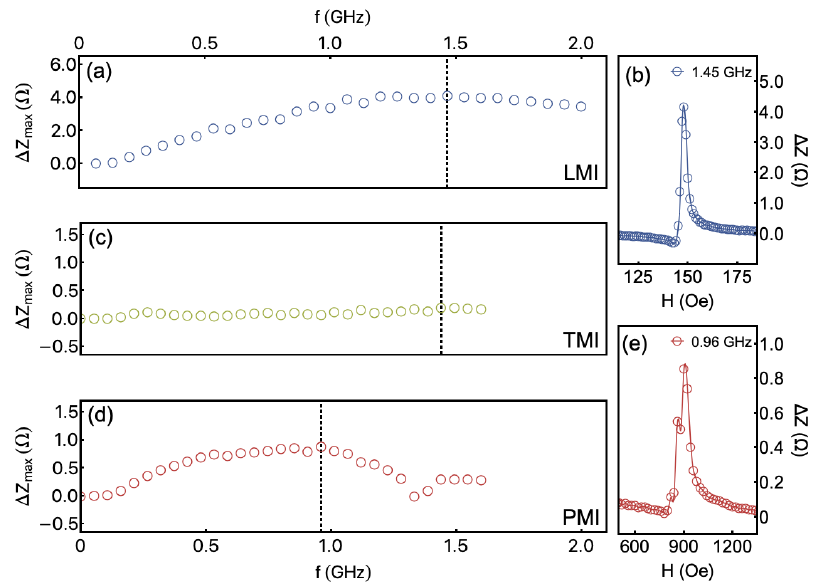
Figure 6. ( a ) Maximum ∆ Z value, ∆ Z max as a function of the frequency for the LMI configuration. The maximum efficiency is found for f = 1.45 GHz, as indicated by the dashed line. ( b ) The ∆ Z vs. H at f = 1.45 GHz, as a representative example of the analyzed curves. The ∆ Z max is achieved from the difference between the Z value at the peak and the Z at the maximum magnetic field. ( c ) ∆ Z max as a function of the frequency for the TMI configuration, whose maximum at 1.4 GHz is indicated by the dashed line. ( d ) A similar plot for the PMI configuration. ( e ) The ∆ Z vs. H at 0.96 GHz for the PMI setup.